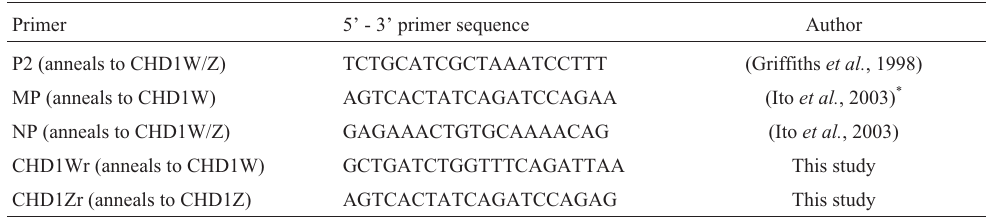
Table 4 - Primers used for molecular sex determination of the harpy eagle ( Harpia harpyja ).